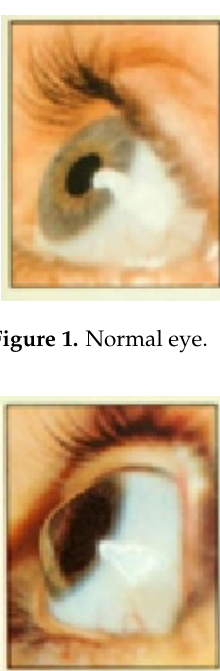
Figure 2. Keratoconus eye.